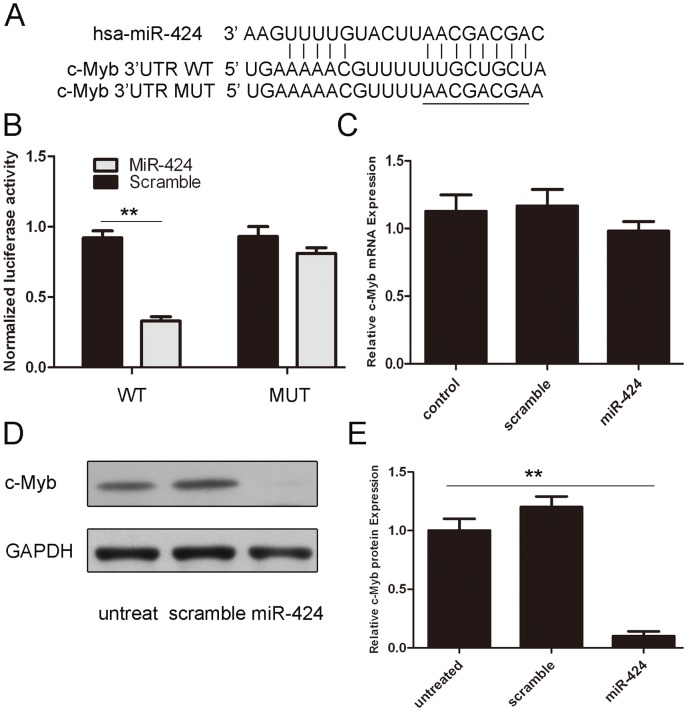
miR-424 targets at c-Myb in HCC cells.(A) The sequences of miR-424 binding sites within the human c-Myb 3′UTRs and schematic reporter constructs, in this panel, c-Myb-WT represent the reporter constructs containing the entire 3′UTR sequences of c-Myb. C-Myb-MUT represent the reporter constructs containing mutated nucleotides. (B) The analysis of the relative luciferase activities of c-Myb-WT, c-Myb-MUT in 293T cells. The error bars are derived from triplicate expriments. (C) qRT-PCR analysis of c-Myb mRNA expression in HepG2 cells after treatment with miRNA mimics or scramble or no transfection. The expression of c-Myb was normalized to GAPDH. (D) (E) Western blot analysis of c-Myb expression in HepG2 cells transfected with miR-424 mimics or scramble or no transfection. GAPDH was also detected as a loading control. ** p<0.01.